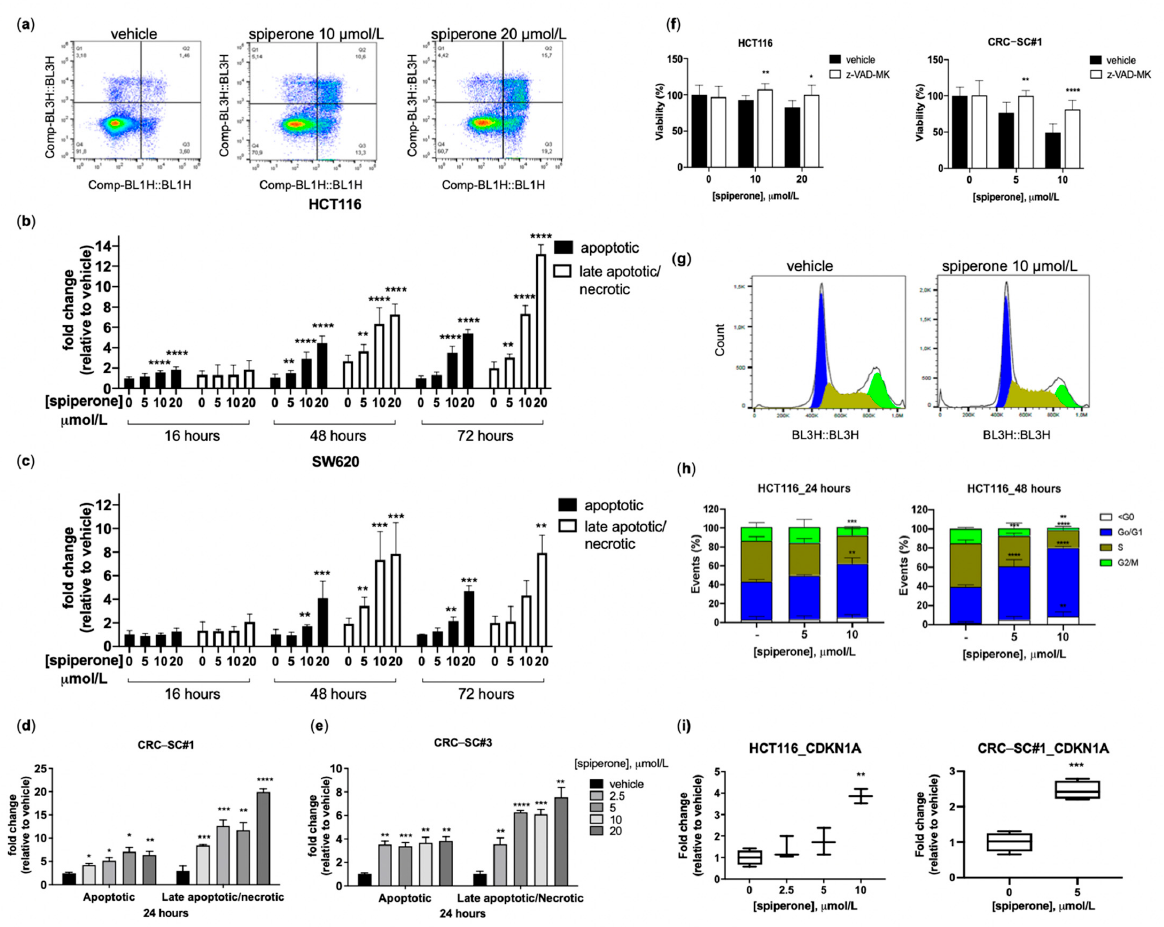
Figure 2. Spiperone induces apoptosis in CRC cells and induces cell cycle arrest in the G1 phase. Representative dot plots showing cell distribution of HCT116 cells treated for 48 h with different concentrations of spiperone after Annexin V/PI (Ax/PI) staining ( a ). Graph showing the analysis of HCT116 ( b ) and SW620 ( c ) cells treated with different concentrations of spiperone at different time points. Graphs showing the analysis of CRC-SC#1 ( d ) and CRC-SC#2 ( e ) cells treated with different concentrations of spiperone for 24 h. Cell populations are indicated as apoptotic (Ax+/PI − ) and late apoptotic/necrotic (Ax+/PI+). Data represent the mean ± SD of at least three independent experiments performed in duplicate. *: Student’s t -test p < 0.05; **: Student’s t -test p < 0.01; ***: Student’s t -test p < 0.001; ****: Student’s t -test p < 0.0001. Cell viability was performed on HCTT16 and CRC-SC#1 cells co-treated for 24 h with different doses of spiperone along with vehicle or 10 μ mol/L zVAD-FMK. Graphs displaying cell viability as the percentage of viable cells; data represent the mean ± SD of at least three independent experiments performed in triplicate. *: Student’s t -test p < 0.05; **: Student’s t -test p < 0.01; ****: Student’s t -test p < 0.0001 ( f ). Representative frequencies of distribution of PI staining were analyzed by flow cytometry of HCT116 cells treated with spiperone for 24 h ( g ). Numbers of cells in the G0, G1, S, and G2 phases of the cell cycle after 24 h and 48 h of treatment with scalar doses of spiperone ( h ); data represent the mean ± SD of at least three independent experiments performed in triplicate. **: Student’s t -test p < 0.01; ***: Student’s t -test p < 0.001; ****: Student’s t -test p < 0.0001. Gene expression analysis of CDKN1A by RT-qPCR. Relative expressions were determined by the ΔΔ Ct method and normalized with the control gene GUSB ( i ); data represent the mean ± SD of at least three independent experiments performed in duplicate. **: Student’s t -test p < 0.01; ***: Student’s t -test p < 0.001.